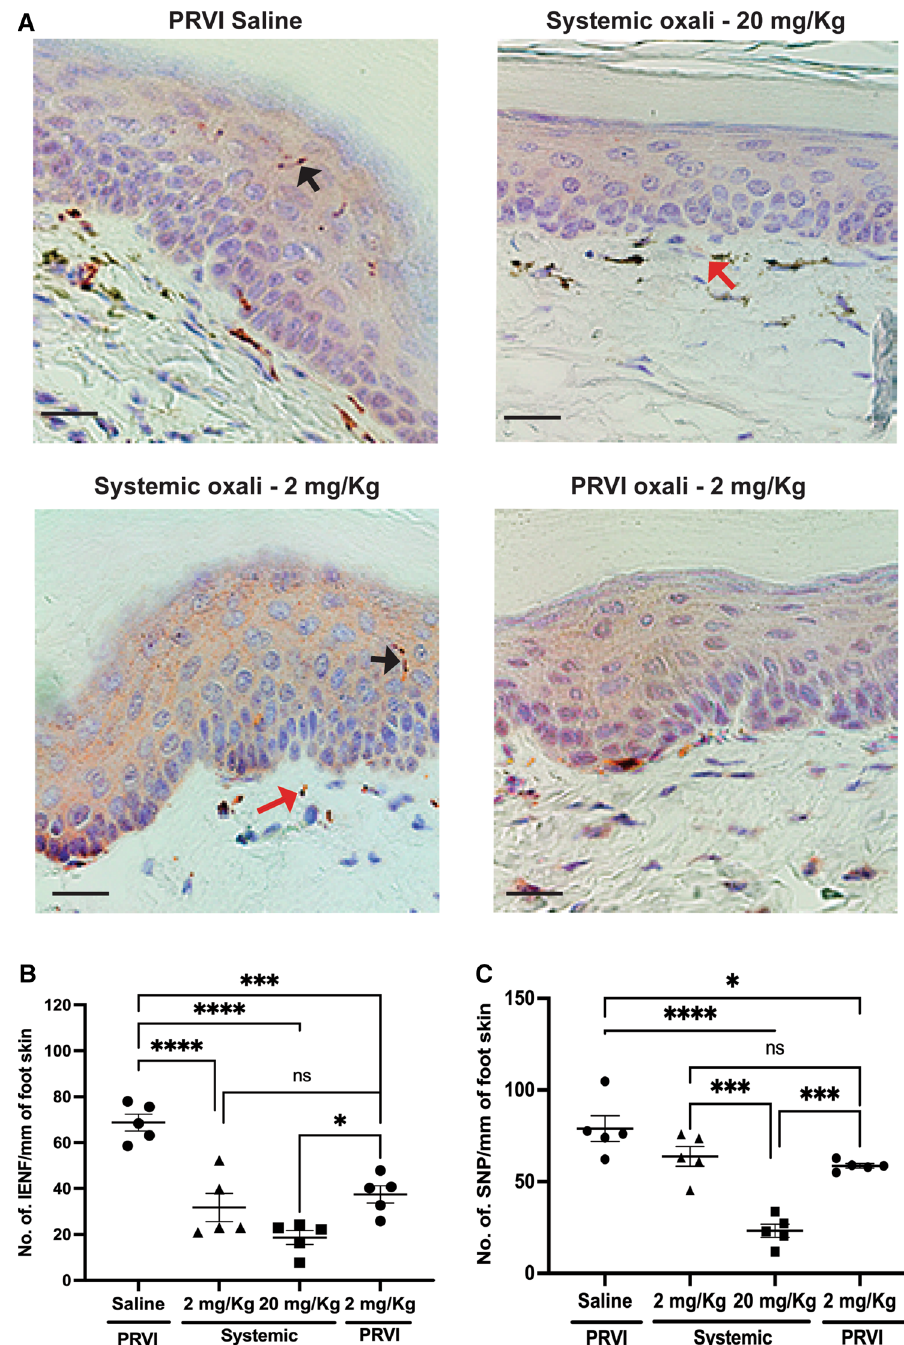
Fig. 3 Neuropathic effects of systemic vs PRVI oxaliplatin delivery. A Immunohisto- chemical staining for the measurement of number of fibers that express PGP 9.5 neuronal marker in foot skin 7 days post oxaliplatin infusion shows the extent of neurodegeneration. Scale bar=20 µm. Black arrow indi- cates IENF and red indicates SNP. The density of B Intra− epidermal nerve fibers (IENF) and C Sub−epidermal Neu- ronal Plexi (SNP) were com- pared between the groups under a light microscope at 20X magnification. Data represented as mean±SEM of 5 mice/group with each data point representing the mean value from 3 regions of inter- est per